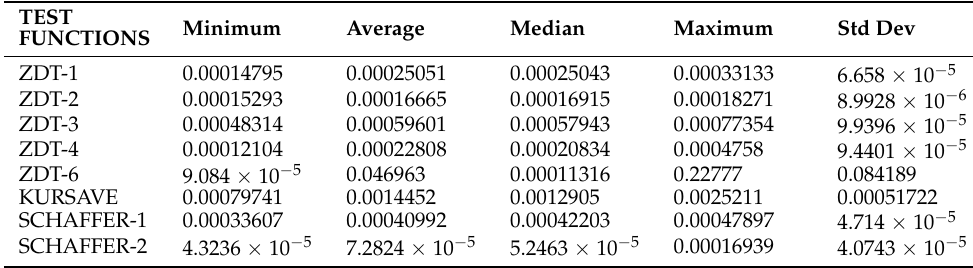
Table 3. Results of GDMETRICS on test functions.